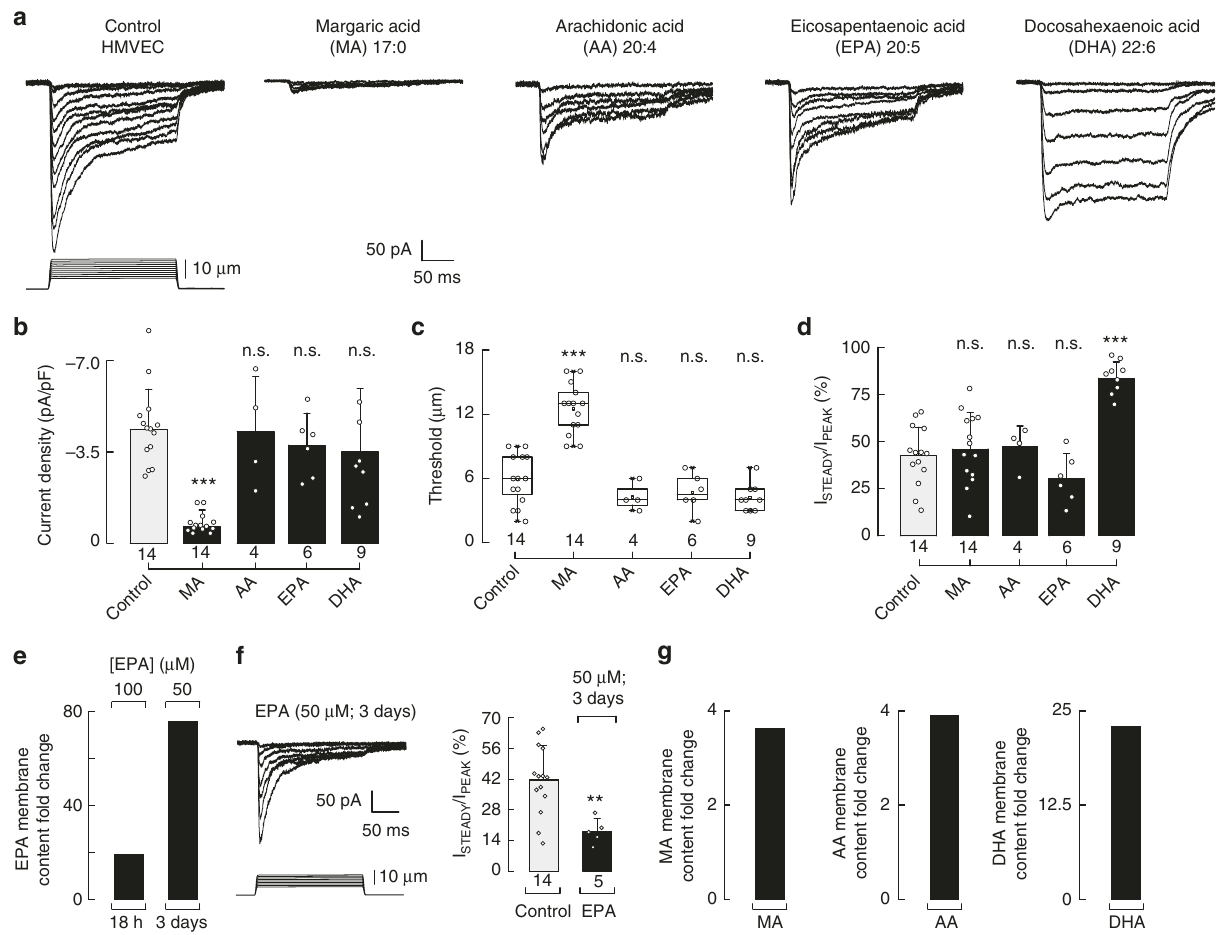
Fig. 5 Dietary fatty acids alter Piezo1 channel gating in HMVEC. a Representative whole-cell patch-clamp recordings (at − 60 mV) of control, MA, AA, EPA, and DHA (100 µ M)-treated HMVEC elicited by mechanical stimulation. b Piezo1 current densities elicited by maximum displacement of control, MA, AA, EPA, and DHA (100 µ M)-treated HMVEC. Bars are mean ± SD. Kruskal – Wallis and Dunn ’ s multiple comparisons test. c Boxplots show the mean, median, and the 75th to 25th percentiles of the displacement threshold required to elicit Piezo1 currents of control and MA, AA, EPA, and DHA (100 µ M)-treated HMVEC. One-way ANOVA and Bonferroni test. d Ratio of the currents at the end of the displacement pulse to the peak current ( I STEADY / I PEAK ) from macroscopic traces of control, MA, AA, EPA, and DHA (100 µ M)-treated HMVEC. Bars are mean ± SD. One-way ANOVA and Bonferroni test. e EPA membrane content fold change of EPA-treated HMVEC supplemented with 100 µ M for 18 h and 50 µ M each day for 3 days, as determined by LC-MS. f Representative whole-cell patch-clamp recordings (at − 60 mV) of EPA (50 µ M each day for 3 days)-treated HMVEC elicited by mechanical stimulation; and ratio of the currents at the end of the displacement pulse to the peak current ( I STEADY / I PEAK ) from macroscopic traces of control and EPA (50 µ M each day for three days)-treated HMVEC. Bars are mean ± SD. Unpaired t -test. g MA, AA, and DHA membrane content fold change in MA, AA, and DHA (100 µ M)-treated HMVEC as determined by LC-MS. Asterisks indicate values signi fi cantly different from control ( ∗∗∗ p < 0.001 and ∗∗ p < 0.01) and n.s. indicates not signi fi cantly different from the control. n is denoted above the x